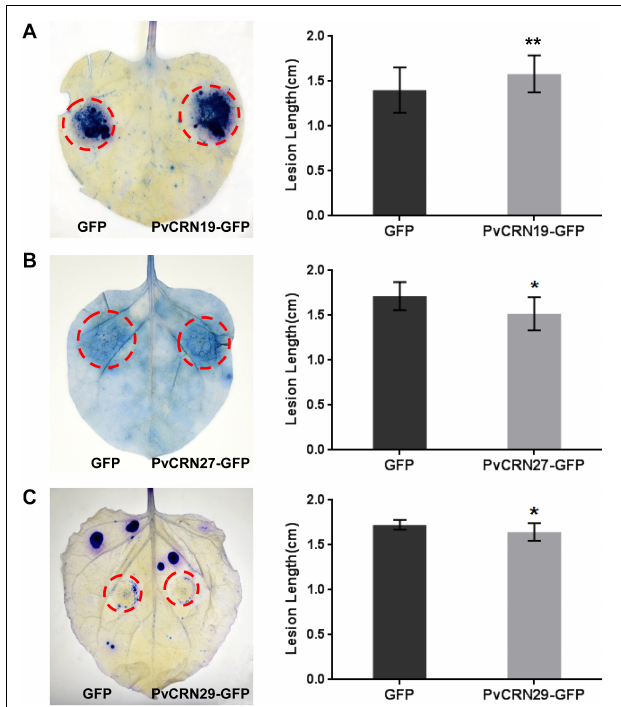
FIGURE 8 | Plant nuclear localized proteins PvCRN19, PvCRN27, and PvCRN29 have different effects on the colonization of N. benthamiana by P. capsici. PvCRN19 made N. benthamiana leaves more susceptible to P. capsici , whereas PvCRN27 and PvCRN29 showed the opposite effect. (A–C) indicate the results for PvCRN19, PvCRN27, and PvCRN29, respectively. Left panel : representative inoculated N. benthamiana leaves stained with trypan blue. The lesions are outlined with red circles. Right panel : mean lesion lengths of N. benthamiana leaf regions in which each PvCRN or the control GFP were expressed. The heights of rectangles represent the mean lesion lengths. Error bars represent SD of 9–12 samples. Asterisks indicate significant differences from the control groups (paired t -test; * p < 0.05; ** p < 0.01). Similar results were obtained in three independent experiments.